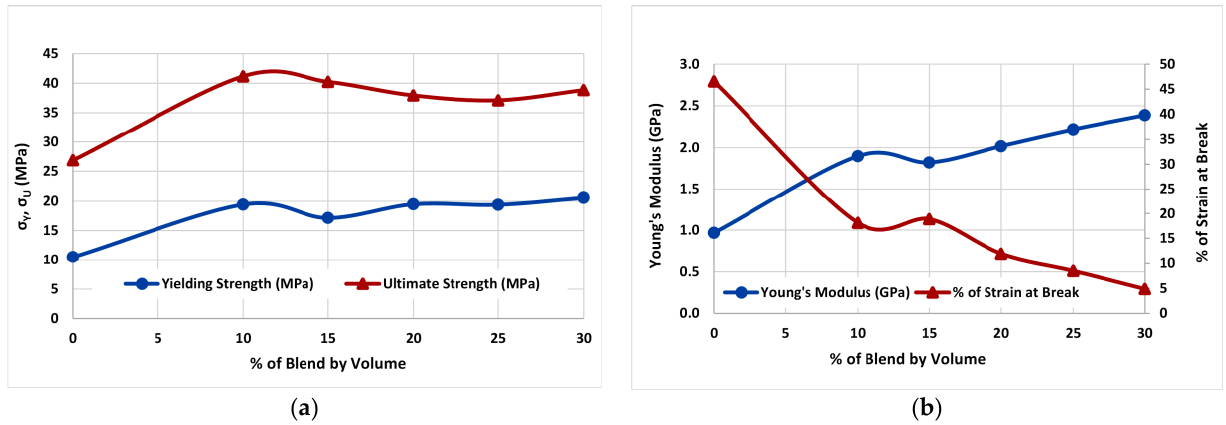
Figure 4. Tendency in changes the mechanical properties of composite polymers with increasing percentage of filler: ( a ) yielding and ultimate strengths; ( b ) Young’s modulus and % of strain at break.